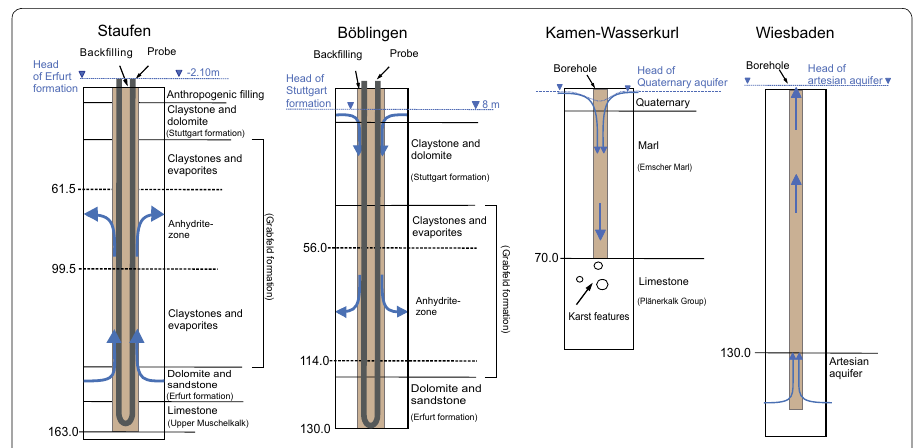
Fig. 4 Process diagrams relating causes and effects of damage in Staufen, Böblingen, Kamen-Wasserkurl, and Wiesbaden to geological conditions and hydrogeological processes. More detailed information on the stratigraphy can be found in publications of the SGD (AD-HOC-AG Geologie 2011; LGRB 2010, 2012, 2016; Wrede